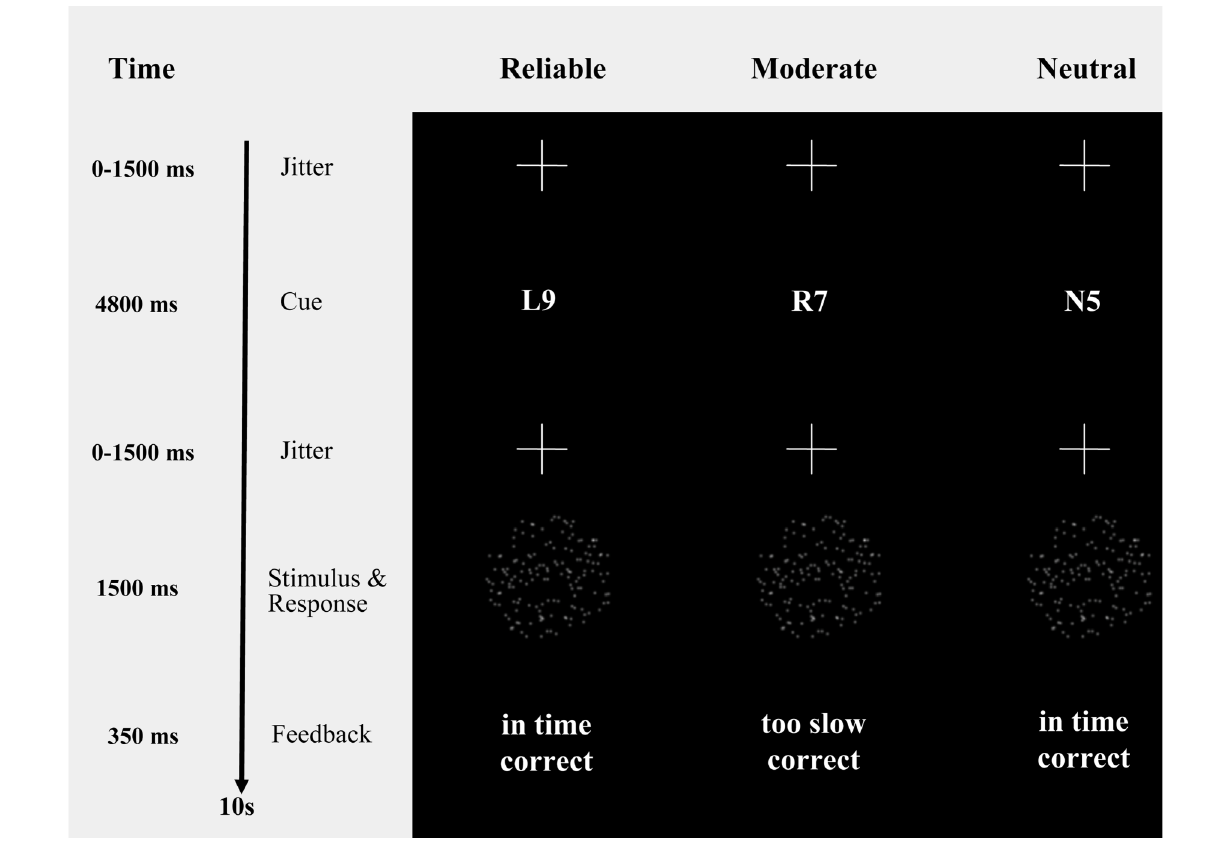
FIGURE 1 | Probabilistic cues in a moving dots paradigm. Moving dots paradigm with cues that provide participants with probabilistic information about the upcoming stimulus (i.e., “R9” and “L9”, reliable cues, indicating a 90% chance of rightward or leftward movement, respectively; “R7” and “L7”,